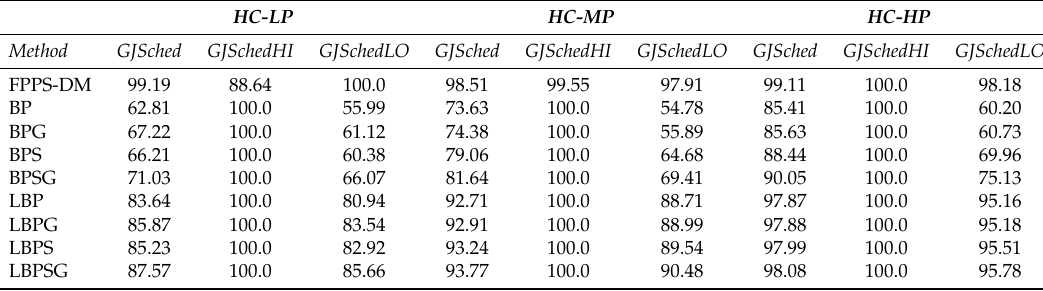
Table 2. BP and LBP variants: comparison of jobs scheduled within their deadline